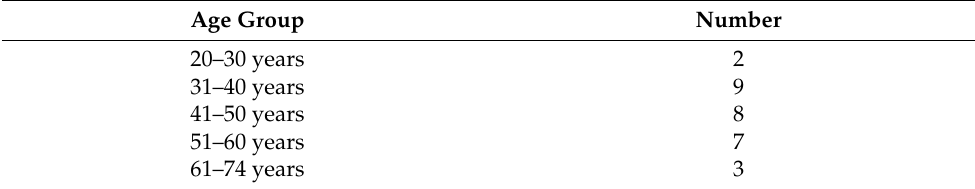
Table 1. The data categorized by age. Information on age is lacking from one